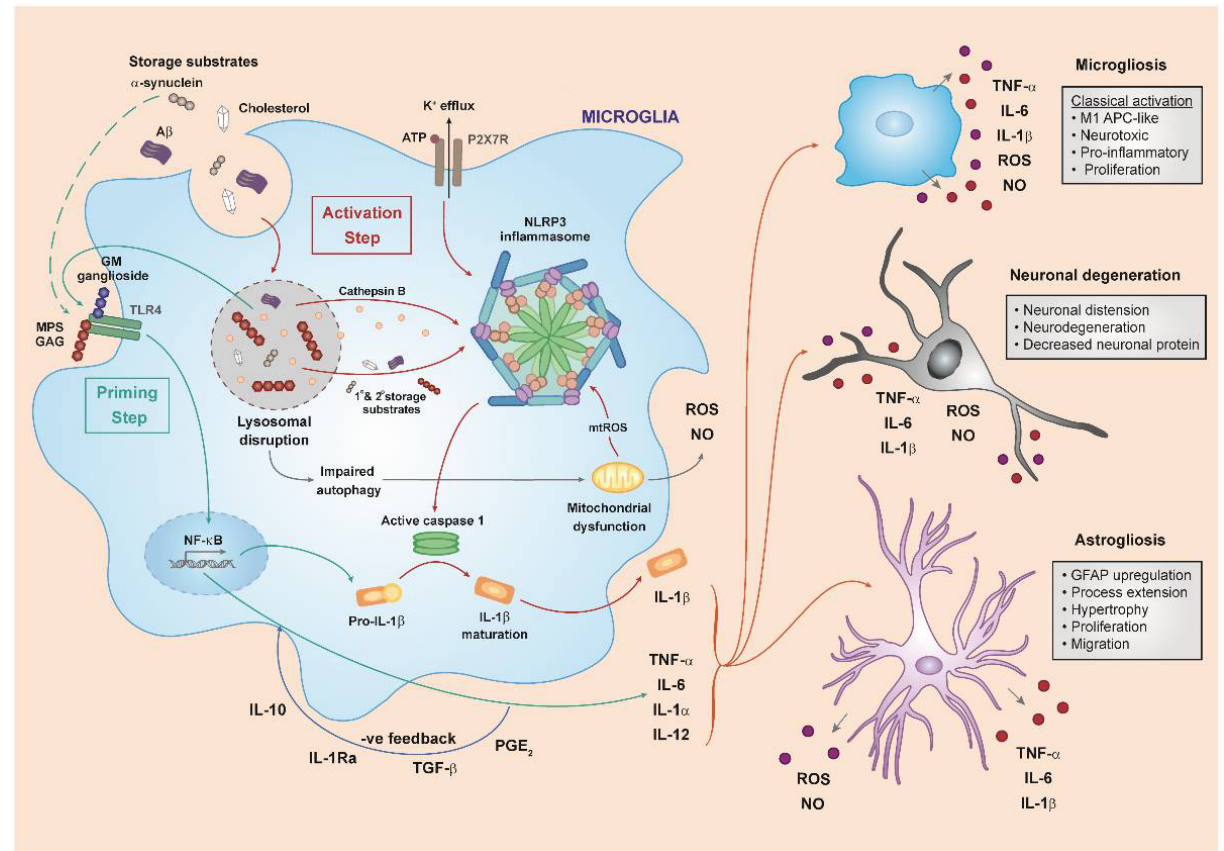
Figure 2. Two-step model for innate immune system activation in MPS diseases. The lack of lysosomal enzyme activity associated with MPS leads to the accumulation of highly sulphated GAG that could either be exocytosed and bind to TLR4 or released intracellularly due to lysosomal disruption. Secondary storage substrates released from cells may also activate TLR4—GM2 ganglioside for example. TLR4 signalling culminates in the activation of the NF-Kb pathway, which promotes pro-IL-1 β and NLRP3 transcription (Priming step), as well as transcriptional induction of other pro-inflammatory cytokines. Many of the pathological events associated with disease progression, such as defective autophagy, lysosomal leakage and cathepsin release, mitochondrial dysfunction, reactive oxygen species, and changes in potassium permeability, can further boost inflammation by triggering the NLRP3 inflammasome assembly and activation (Activation step). This eventually leads to secretion of mature IL-1 β via caspase-1 cleavage which, together with the other pro-inflammatory cytokines, causes multiple downstream events, such as microglia and astrocyte activation and neuronal degeneration, including